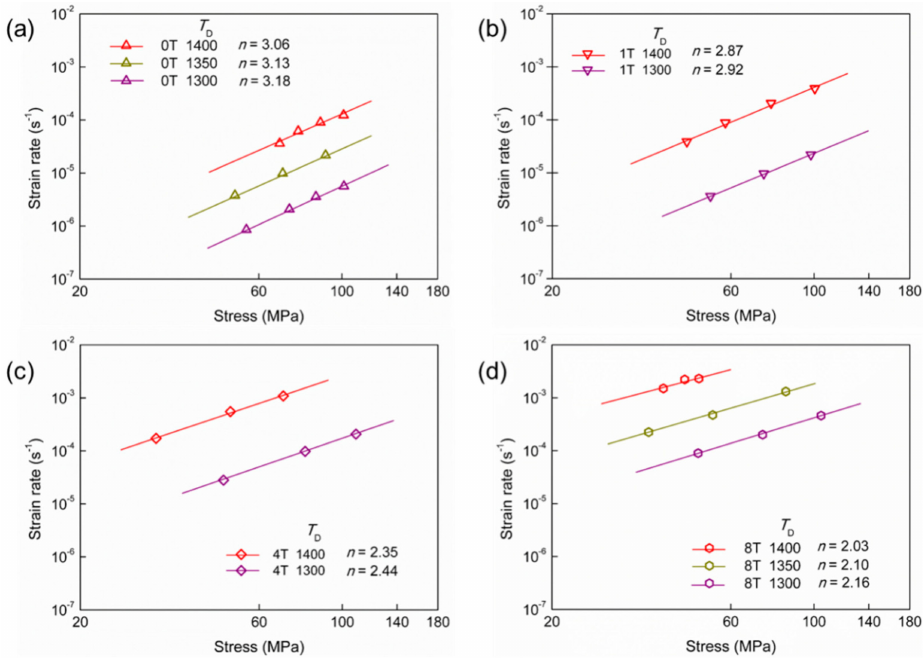
Figure 2. Stress-strain rate relationship of ( a ) 0T, ( b ) 1T, ( c ) 4T and ( d ) 8T under the deformation at 1300–1400 ◦